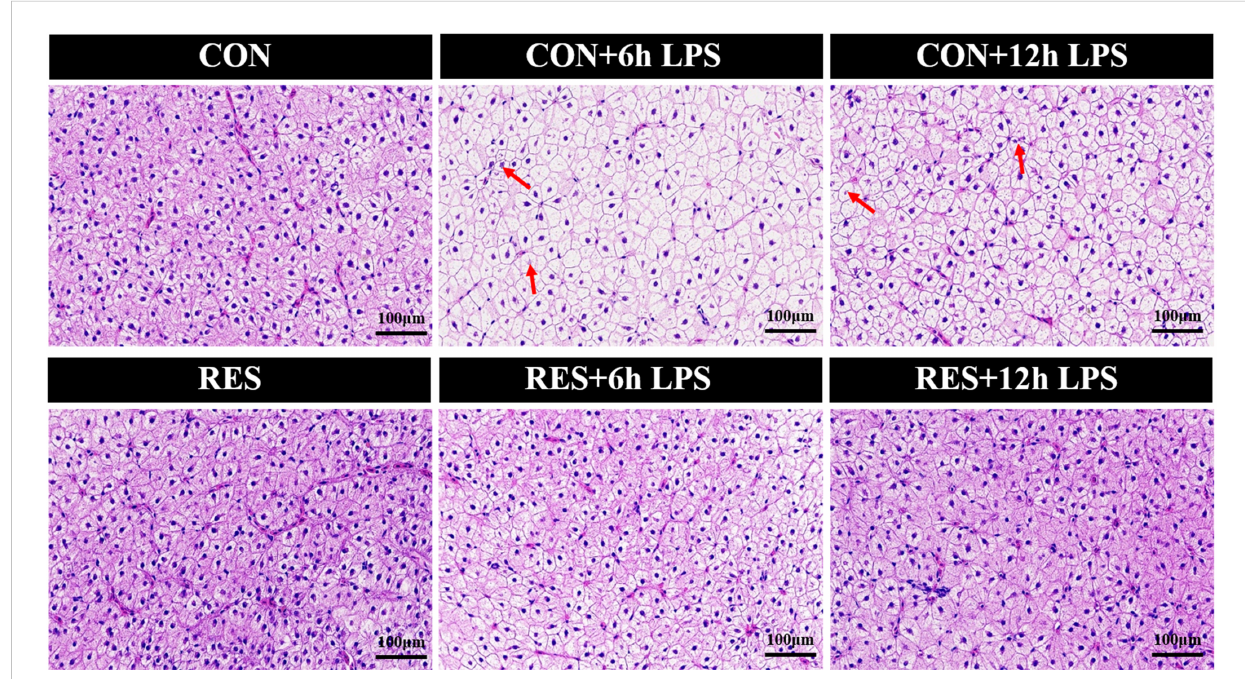
FIGURE 2 Effect of dietary RES on H&E staining of liver tissue in gibel carp at 6 h and 12 h after LPS injection.